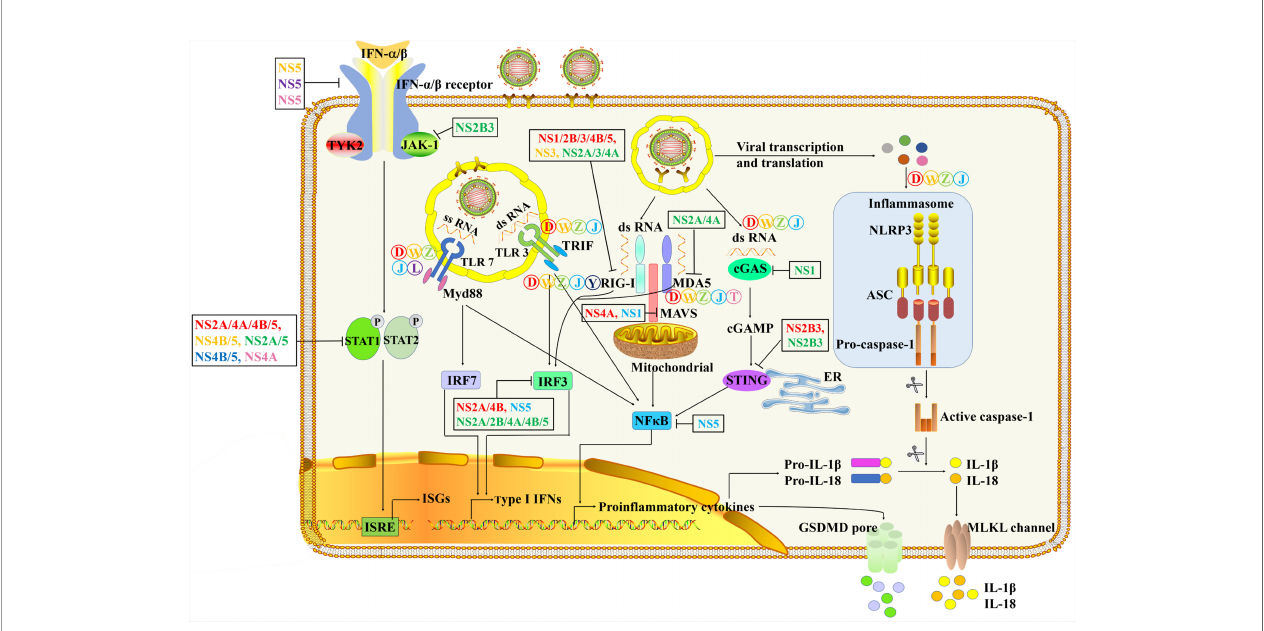
FIGURE 3 | The innate immune pathways in the process of fl avivirus infection and immune evasion. After fl avivirus infection, TLR3 and TLR7 recognize double- stranded RNA (dsRNA) and single-stranded RNA (ssRNA), respectively. It then triggers a signal cascade downstream of the TLRs to induce the activation of NF- k B to produce pro-in fl ammatory cytokines and phosphorylation of IRF/7 to drive the production of type I IFN (24 – 32). The dsRNA RNA in the cytoplasm is recognized by RIG-I and MDA5 (33 – 36). The combination of RIG-I and MDA5 with MAVS leads to the activation of NF- k B and the phosphorylation of IRF3 (37 – 41). Severe fl avivirus can also stimulate the formation of in fl ammasomes, leading to caspase-1 activation and release of the cytokines IL-1 b and IL-18 (42 –